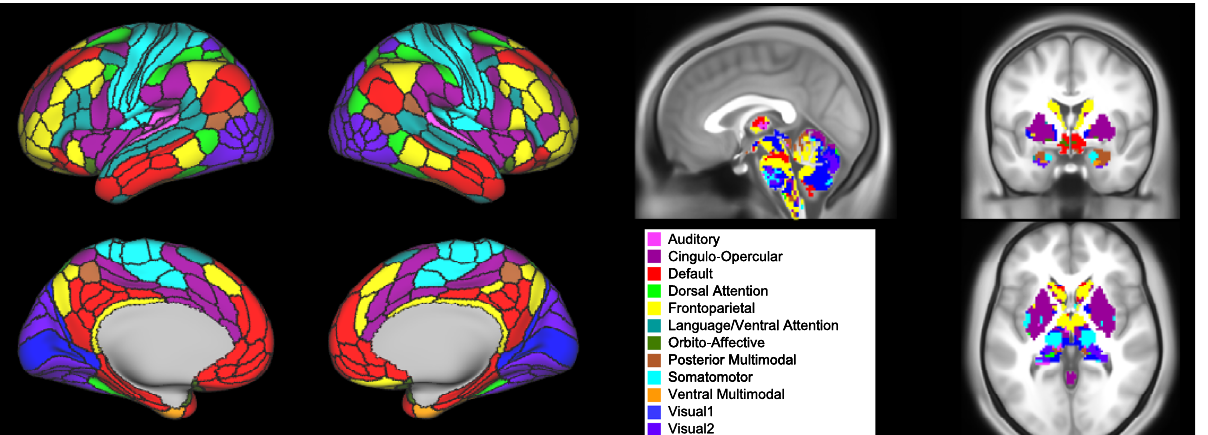
Fig. 2 Cole-Anticevic brain-wide network partition (CAB-NP). We conducted a whole-brain parcellation and assigned brain parcels to 12 large-scale networks according to the Cole-Anticevic brain-wide network partition (CAB-NP) parcellation 23 . This parcellation built on the Glasser multimodal cortical parcellation by including subcortical and cerebellar parcels, and assigned each of the 718 parcels to a large-scale brain network using Louvain community